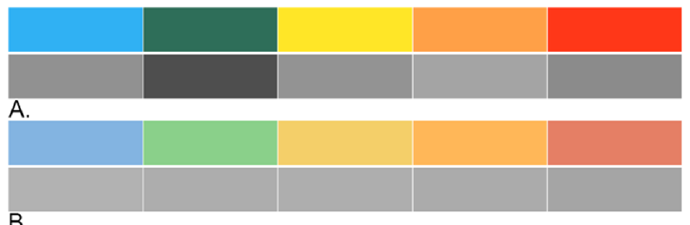
Figure 5. Colour saturation and luminance . Comparison of a high-saturation colour palette and the corresponding greyscale values ( A ) with a low-saturation colour palette and corresponding greyscale values ( B ).